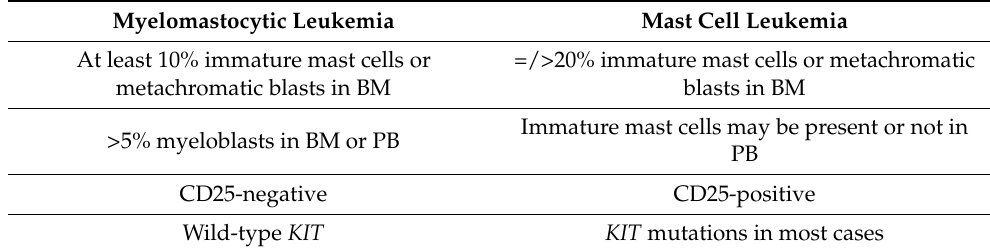
Table 5. Diagnostic criteria of MML and